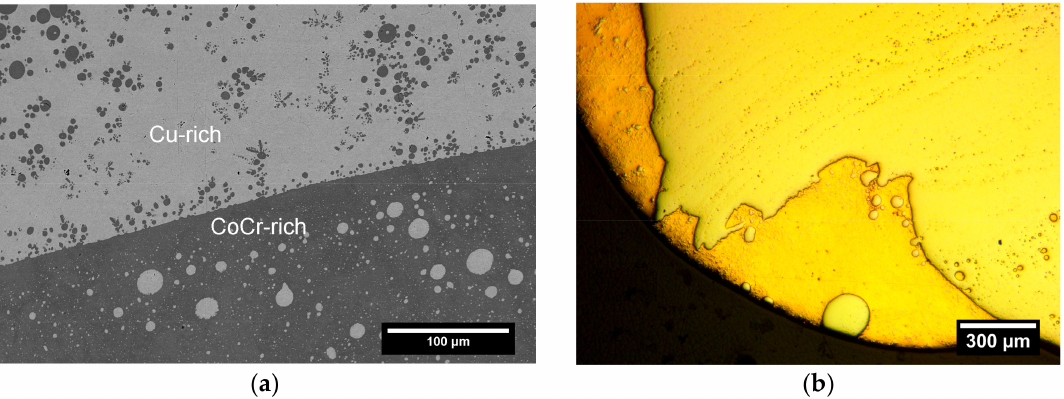
Figure 4. ( a ) Backscattered electron image of CoCrCu displaying 2 distinct phases: Cu-rich (top), CoCr-rich (bottom). Note, tiny black spots are pores generated from the initial grinding/polishing process. ( b ) Optical micrograph of the bottom-half cross-section of an arc-melted CoCrCu